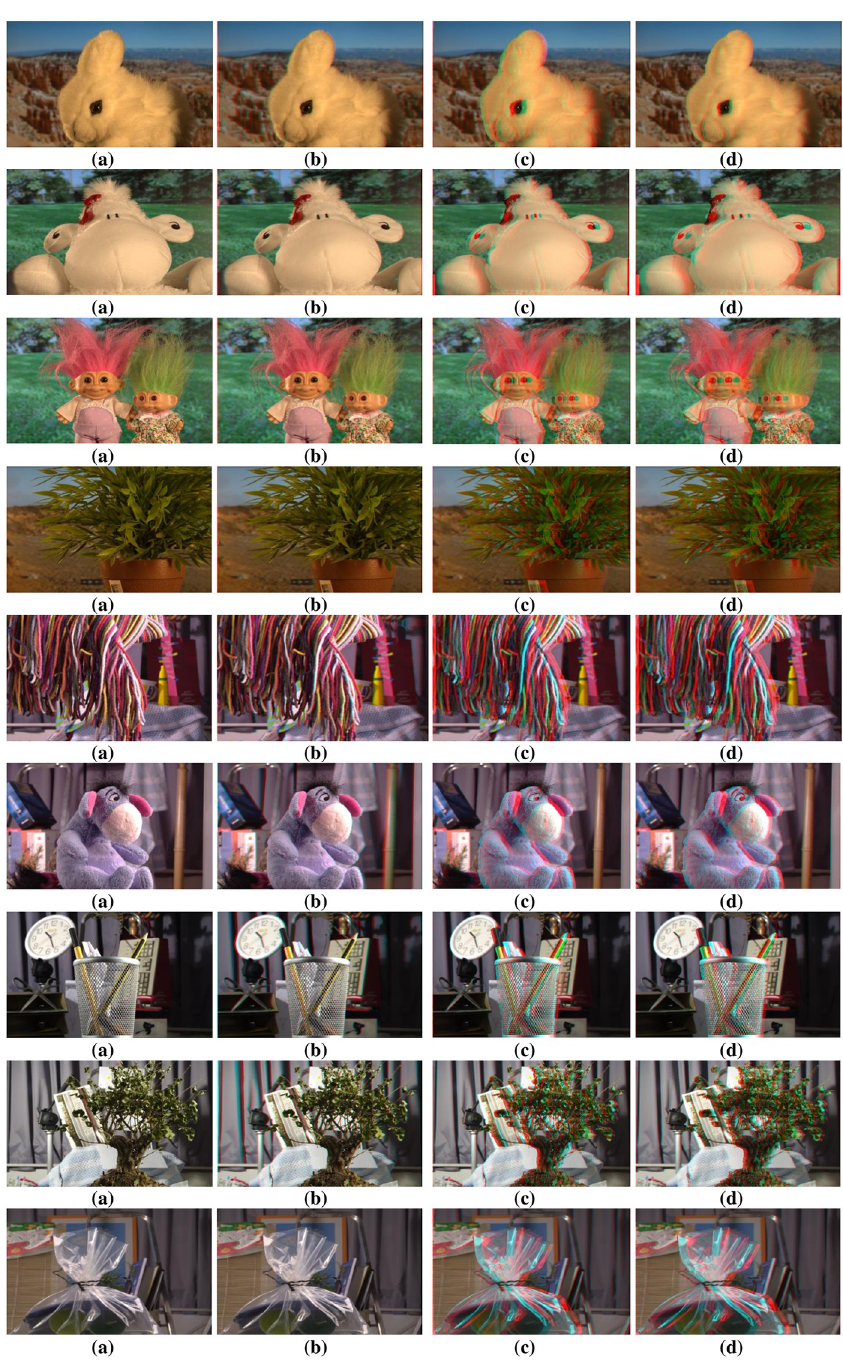
Fig 11. Anaglyph results of dataset [37]. ( a ) Input Images ( b ) Anaglyph produced by Zhuo.et al. [12] ( c ) Anaglyph produced by Yang.et.al. [26] and ( d ) Anaglyph generated by DFB-DIBR.